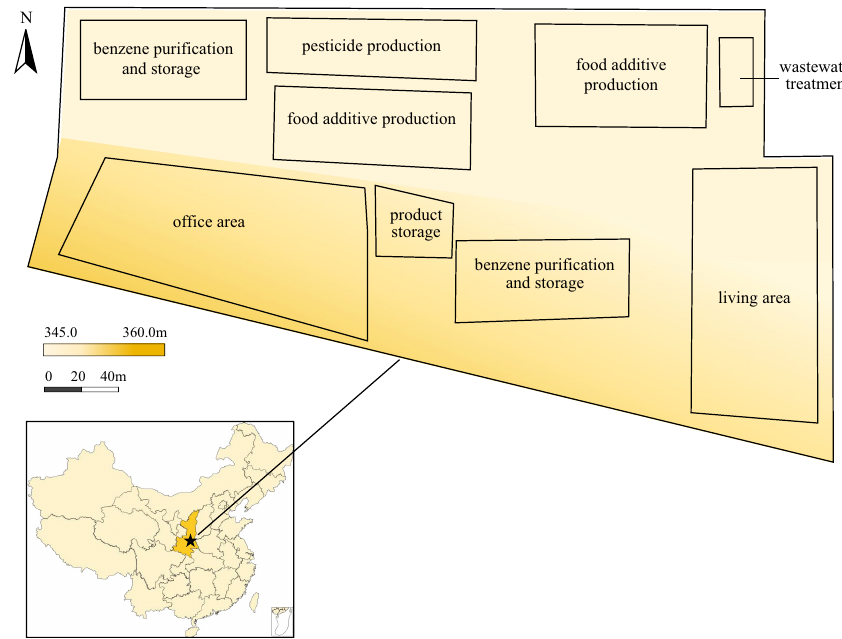
Figure 1: The layout and location of the chemical